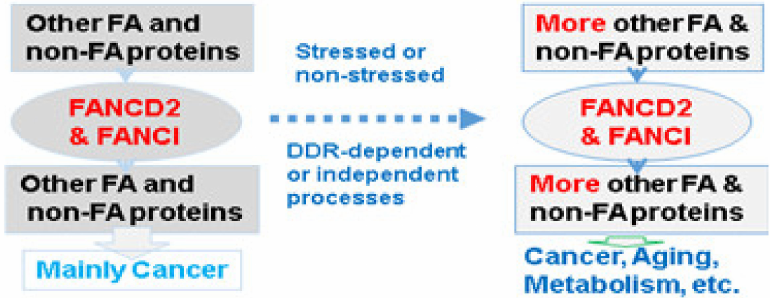
Figure 2. Illustrating functional roles of FA signaling with a relatively defined focal